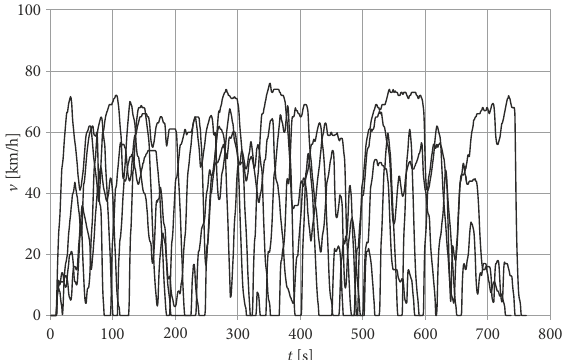
Figure 1. CT test (stochastic process of vehicle speed) for street congestions